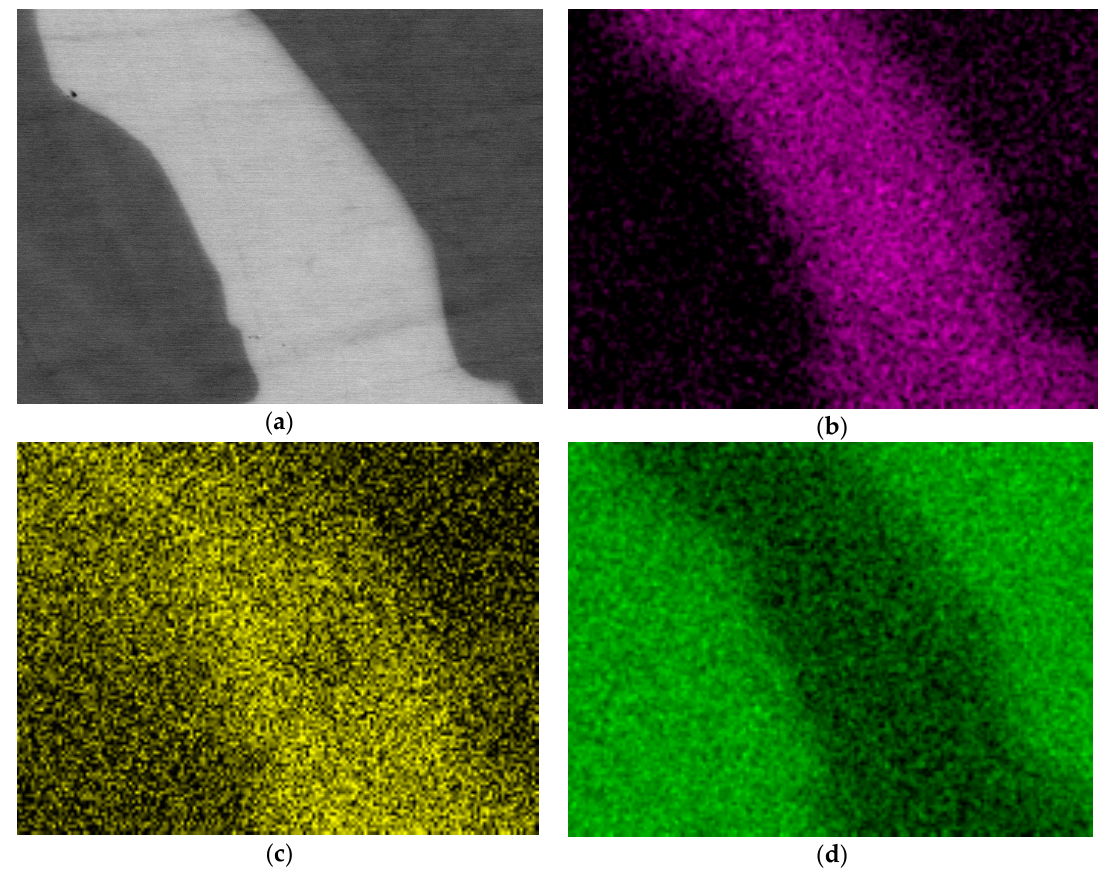
Figure 5. Chemical composition distribution map of the La 0.5 Ce 0.5 Ni 5 sample: (a) BSE image, (b) La distribution map, (c) Ce distribution map and (d) Ni distribution map.